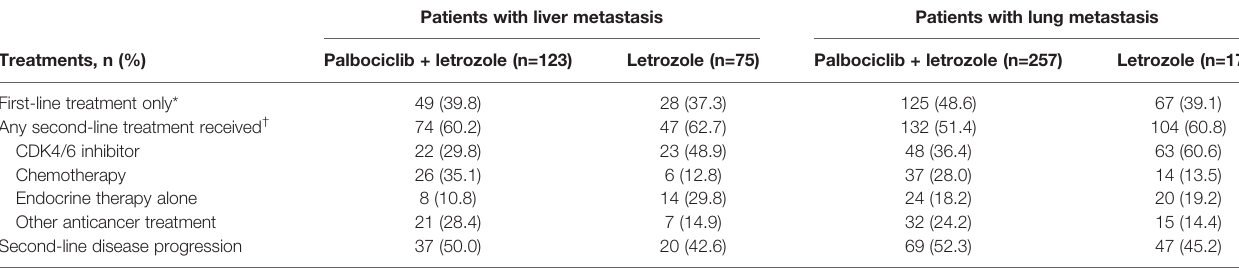
TABLE 2 | Subsequent second-line anticancer treatments and disease progression in the second-line treatment. Patients with liver metastasis Patients with lung metastasis Treatments, n